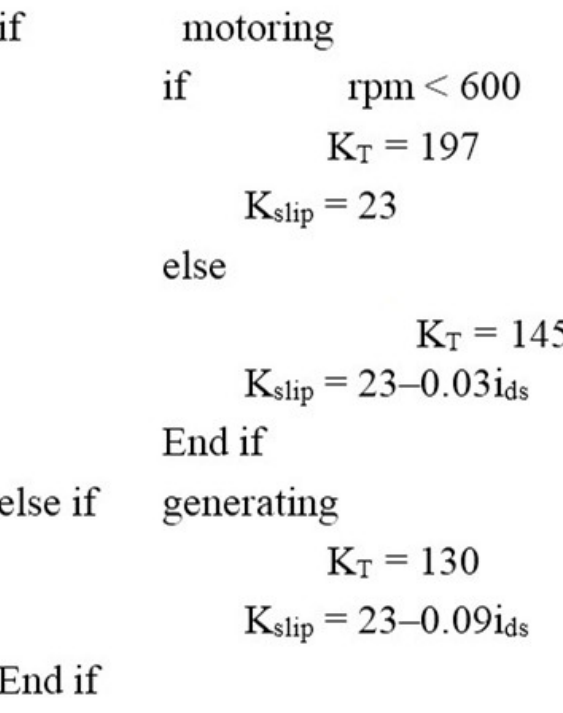
Figure 7. Experimental results for efficiency and flux current. a1 – a4 : optimal flux current versus power at 2000, 3000, 4000 and 4500 rpm respectively; b1 – b4 : Efficiency calculation with optimal flux level at 2000, 3000, 4000 and 4500 rpm respectively.